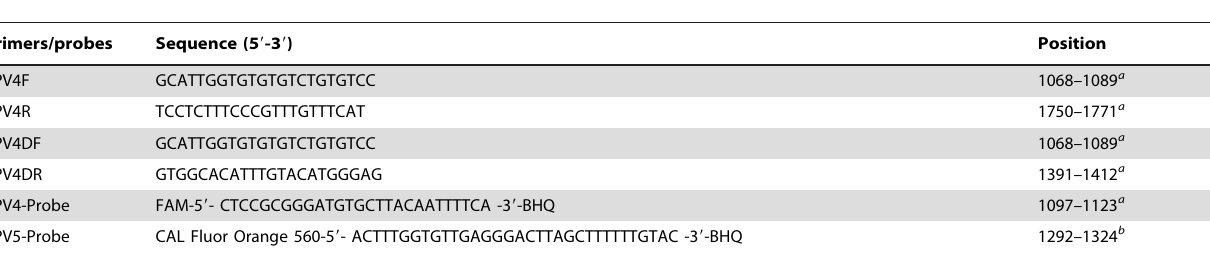
Table 3. Primers and probes used for PPV4 and PPV5